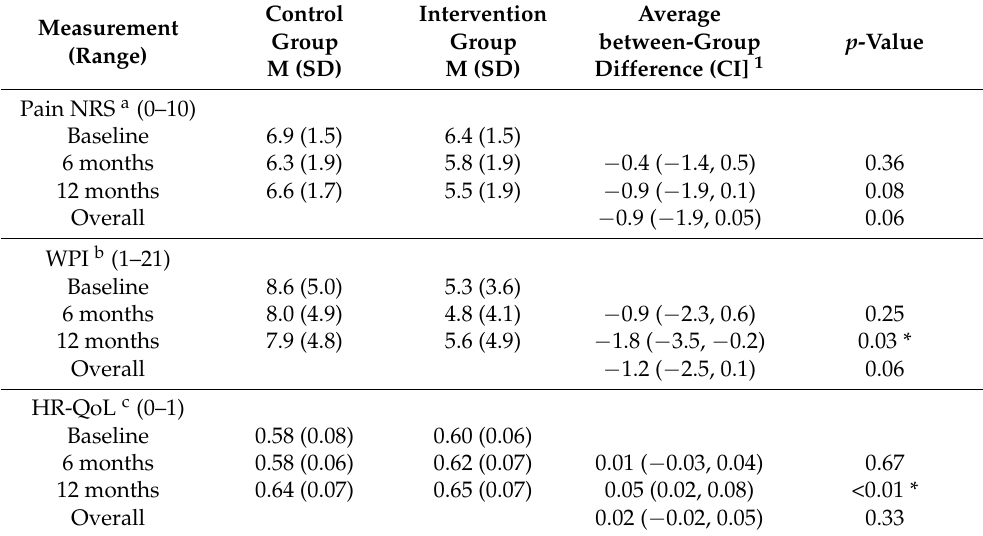
Table 2. Effects over time: Primary outcomes 1 .